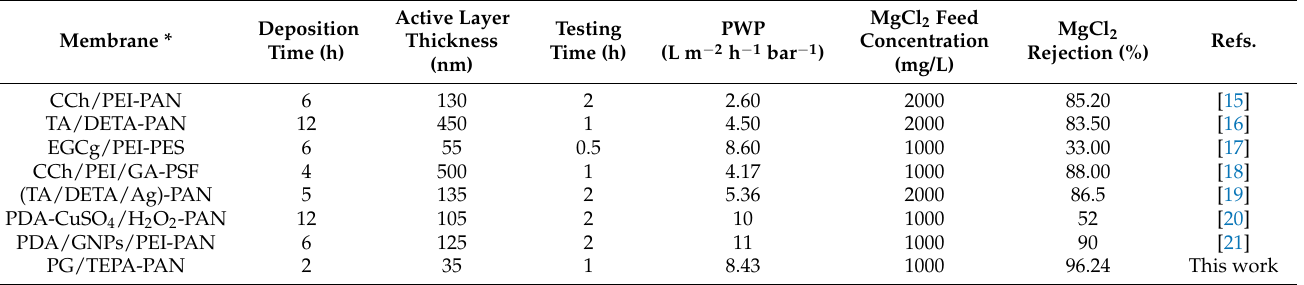
Table 1. Comparison of the separation performances of various polyphenol and polyamine NF membranes.